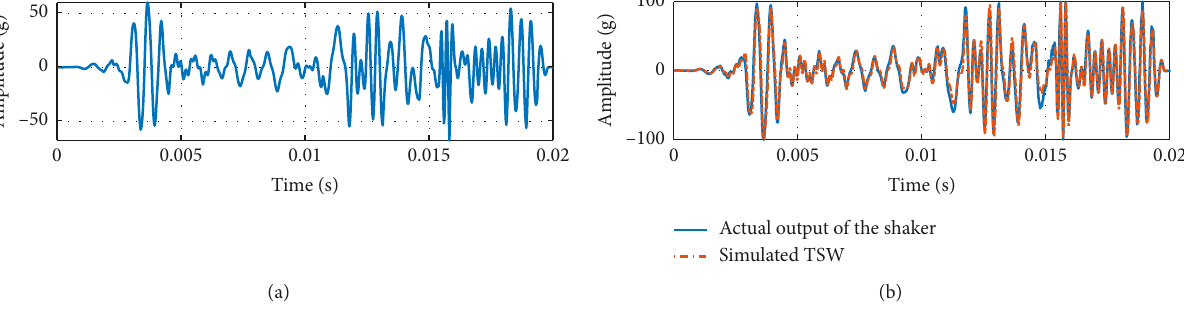
Figure 16: (a) Input and (b) output of the shaker.